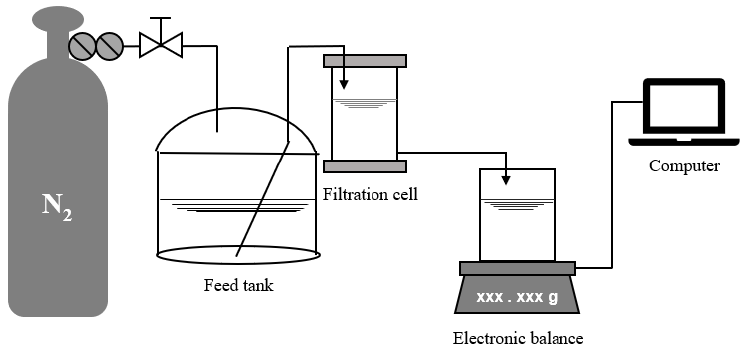
Figure 1. Low-pressure MF/UF dead-end filtration setup.